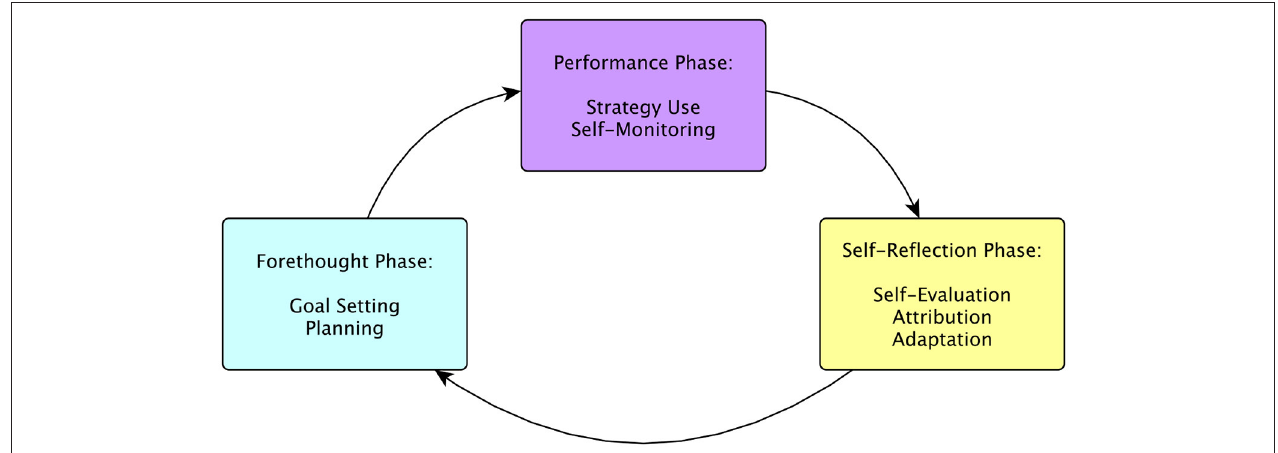
FIGURE 1 | An overview of the cyclical phase model of self-regulated learning highlighting the specific processes examined in this work and which phase they belong to. learning the skills and mechanics involved in playing a game.